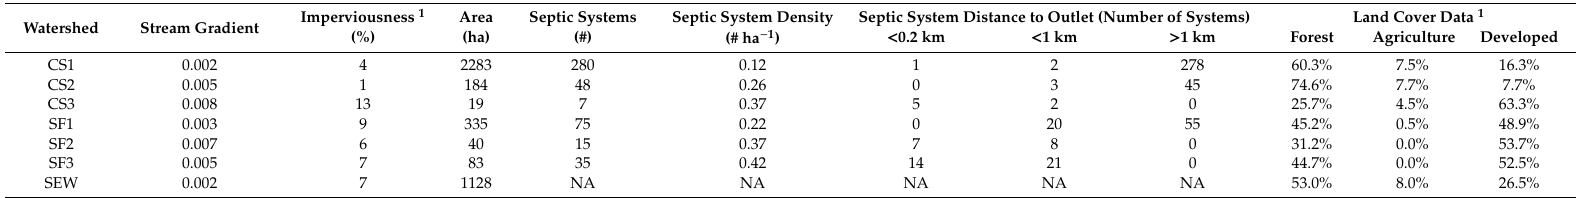
Table 1. Watershed characteristics, septic system density, and proximity of septic systems to watershed outlets. CS = conventional septic; SF = sand filter; SEW = sewer.